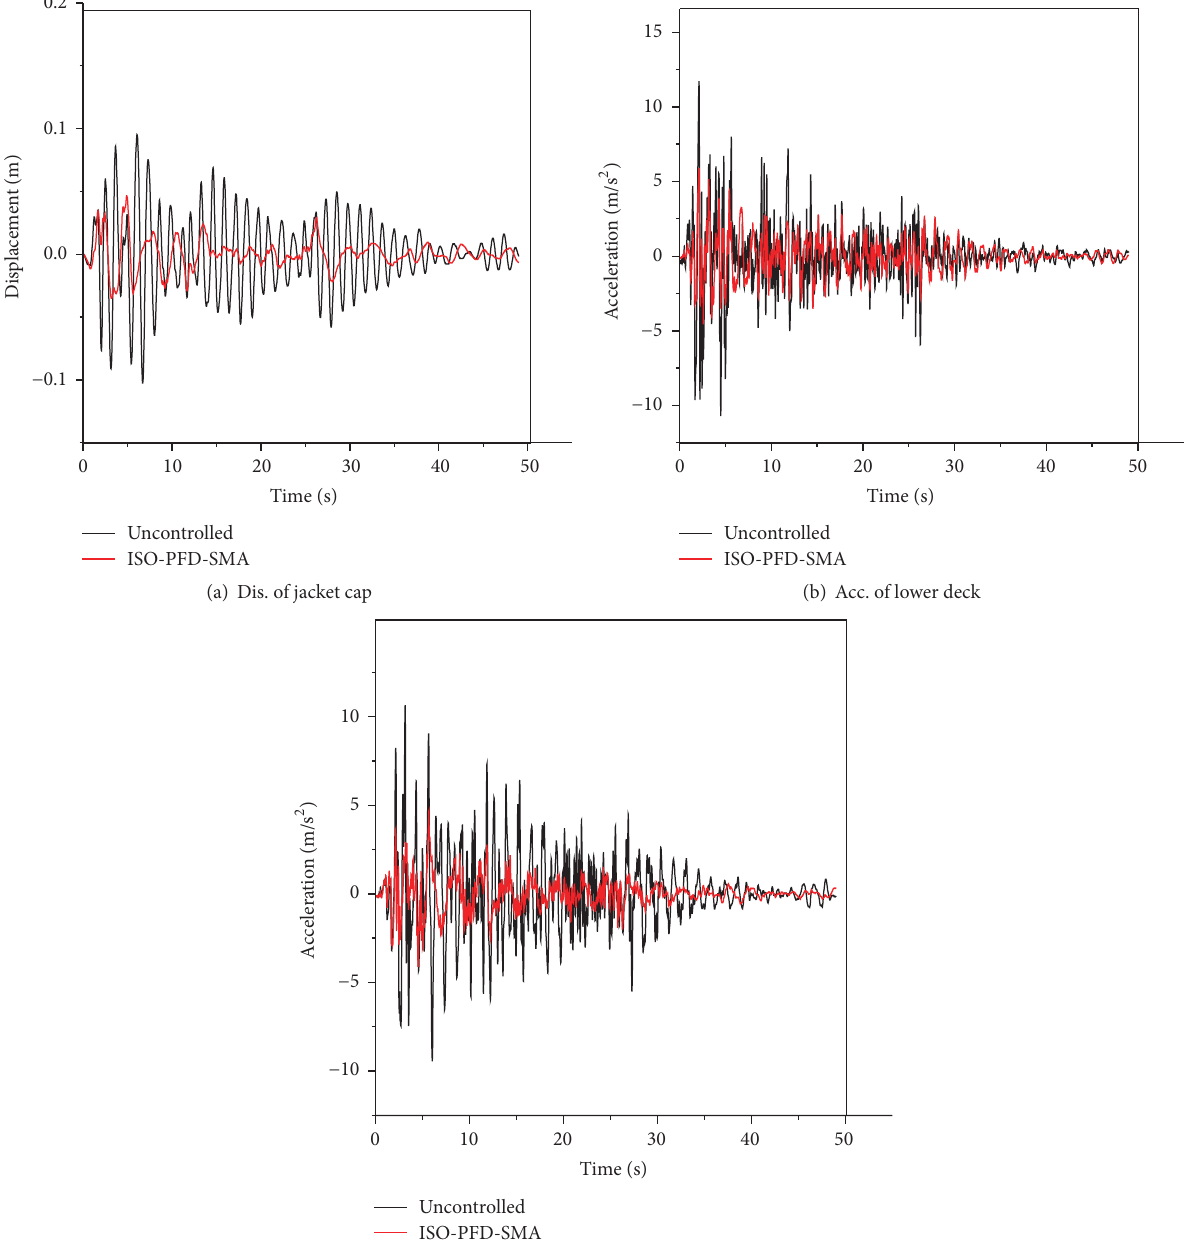
Figure 14: Computational response of JZ20-2MQU model under El Centro earthquake